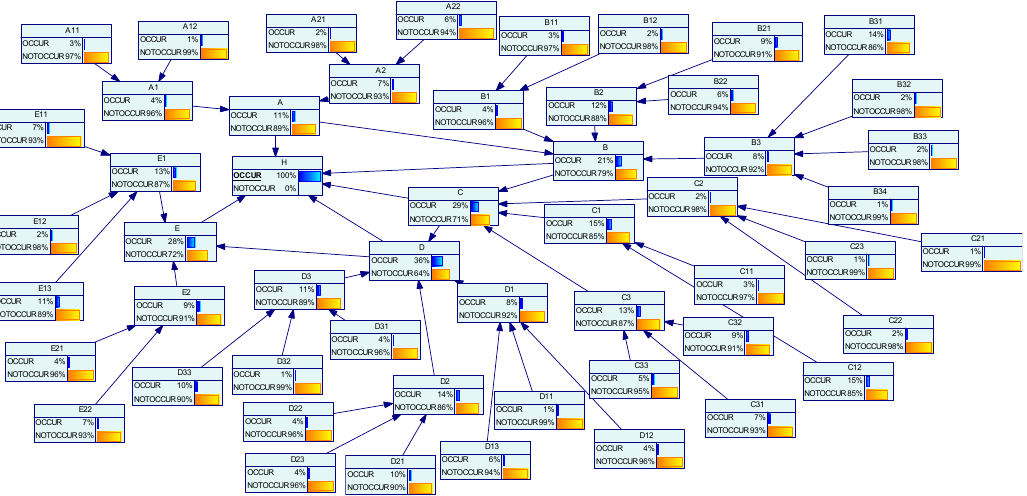
Figure 6. BN reverse reasoning of safety accidents in hoisting construction of prefabricated components.